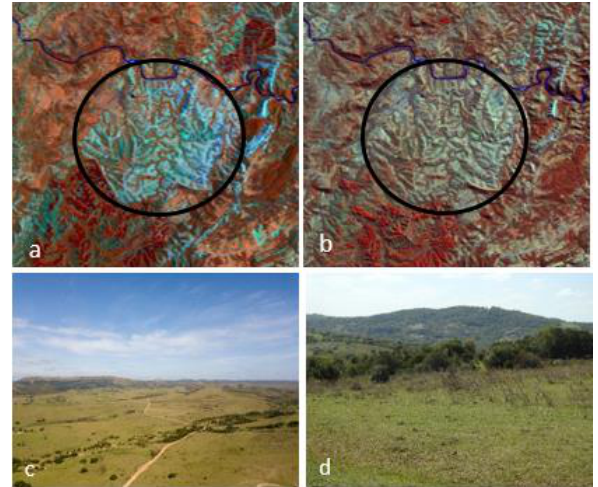
Figure 10. Example of native grassland management for cattle at Pampa – Landsat/OLI image in 2016 (a) and 2019 (b) and (c, d) photography during field campaign in 2019 (-31.028979; - 53.332198).